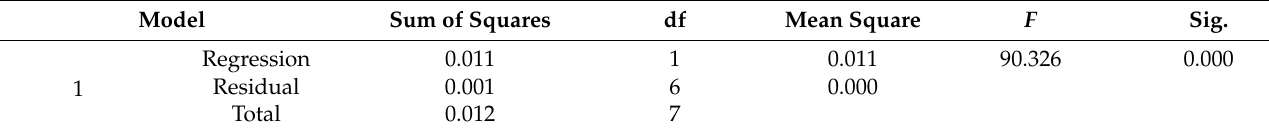
Table 13. Variance analysis of PCR.